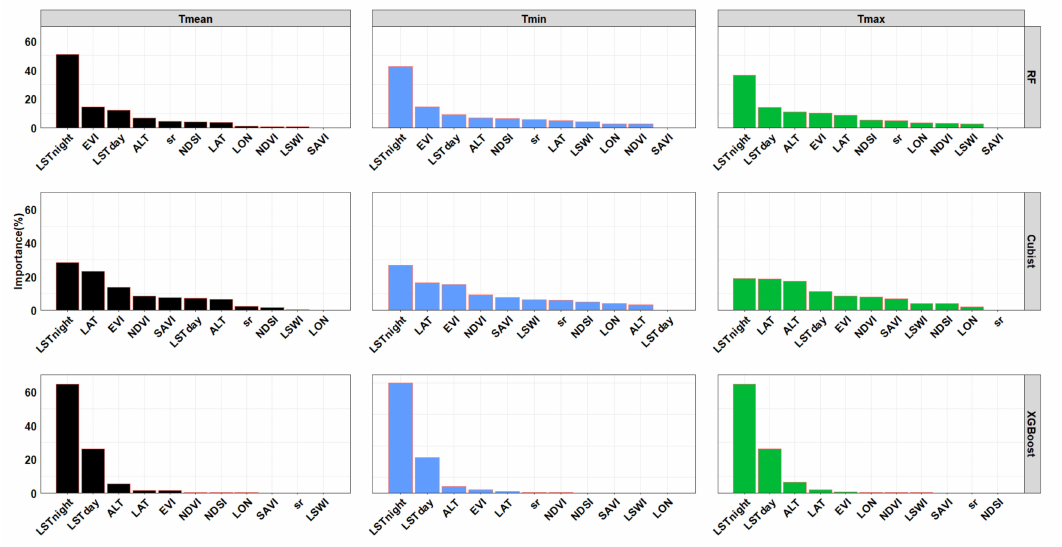
Figure 6. Tmean, Tmin, and Tmax temperature residuals showed varying temporal sensitivity to physiographic drivers. Each variable was scaled to a total of